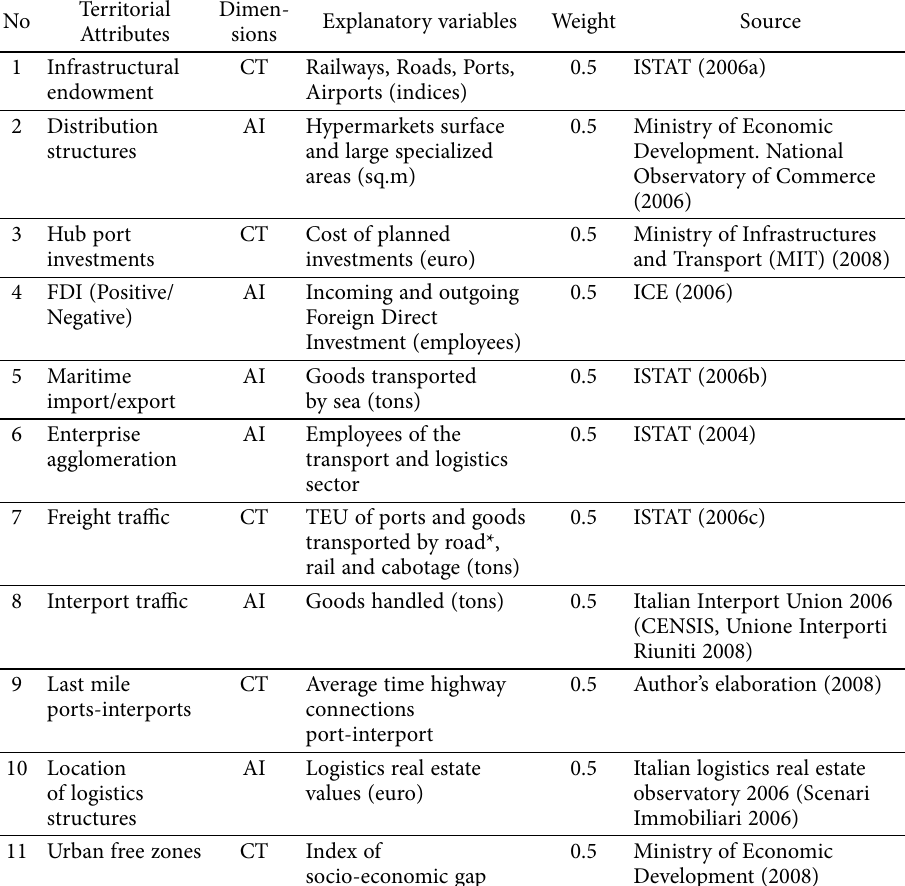
Table 6. Territorial attributes and variables – ACIT Port